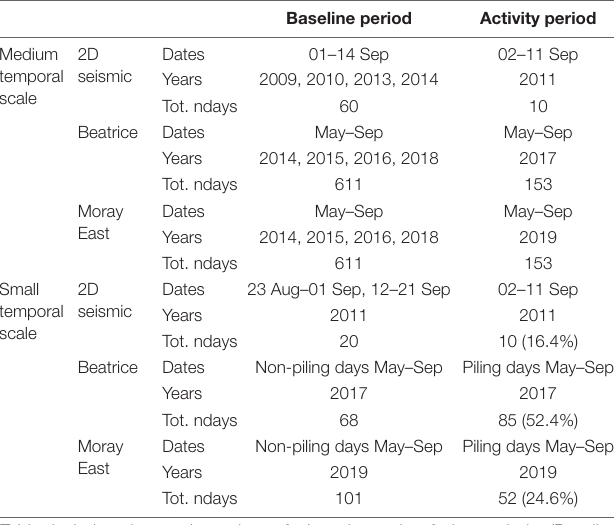
TABLE 2 | Data used in the BACI analyses for the medium and small temporal